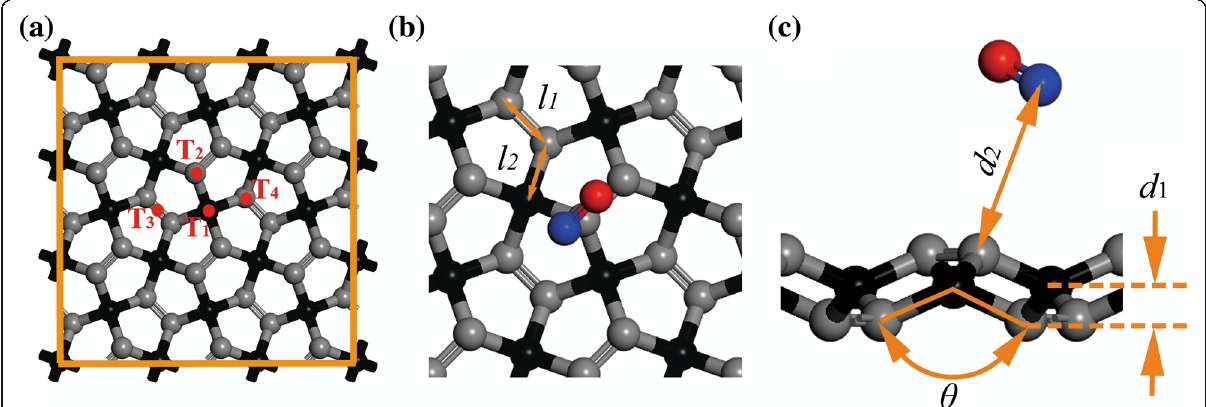
Fig. 1 Structure and geometry of PG: a 3×3 supercell, b front view of unit cell, and c side view of the adsorbate-PG atoms. The distance between two C2 atoms, the distance between C1 and C2 atoms, the thickness of PG, and the C2-C1-C2 angel are defined as l 1 , l 2 , d 1 , and θ ,